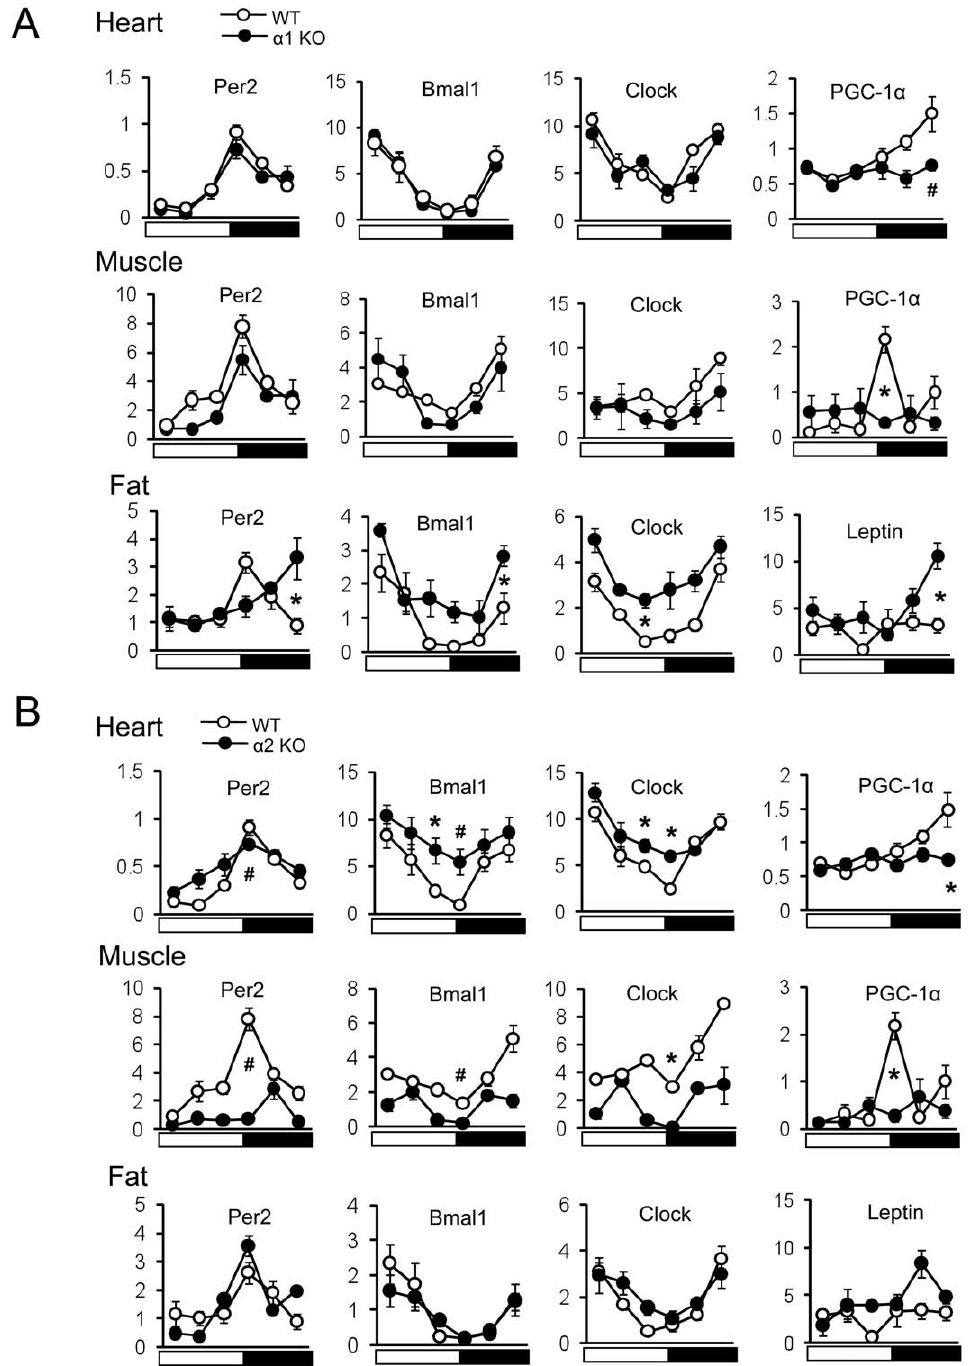
Figure 5. Clock and clock related gene expression in heart, skeletal muscle and fat in (A) AMPK a 1 2 / 2 , (B) AMPK a 2 2 / 2 and WT mice. mRNA levels of mPer2, Bmal1, Clock, PGC-1 a and leptin were measured by real-time PCR. The relative levels of mRNA are presented in arbitrary units. Light on is indicated by a white bar and light off is indicated by a black bar. The same WT data is plotted in A and B. Results are mean 6 S.E. * P , 0.05, # P , 0.001 between WT versus AMPK a deficient mice (n=4–5 for each time point). doi:10.1371/journal.pone.0018450.g005 Circadian oscillation of Nampt mRNA and NAD + in the fat of both AMPK a 1 2 / 2 and AMPK a 2 2 / 2 mice. Therefore, although the role of each isoform of AMPK in production requires AMPK generating the cyclic expression pattern of core clock genes AMPK has been shown to increase the expression of Nampt correlated with their relative abundance in peripheral tissues, the and the product of its enzymatic reaction, NAD + [51,52]. Since the circadian oscillation of NAD + levels promotes circadian cyclic expression pattern of PGC-1 a and leptin did not.